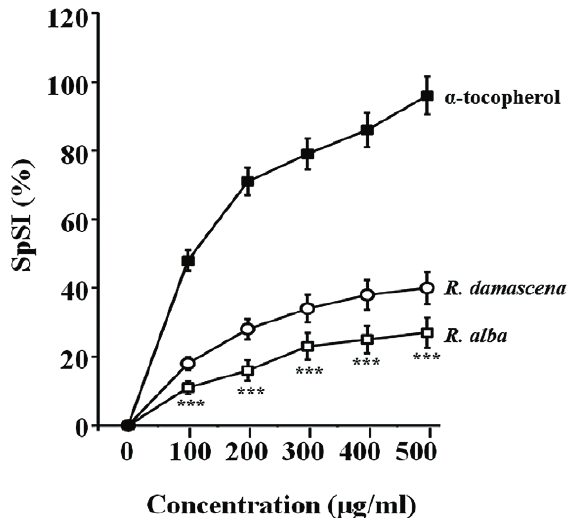
Figure 1. Superoxide scavenging activity of Rosa alba L. essential oil. Data were calculated in percentage as spectrophotometric scav- enger index (SpSI) – the ratio of the absorption at 560 nm for the sample with oil, and the same absorption for the controls (without oil). The essential oil from Rosa damascena Mill. was used as a con- trol. Data are expressed as mean ± SD of three independent experi- ments. ***p<0.001 compared with alpha -tocopherol.